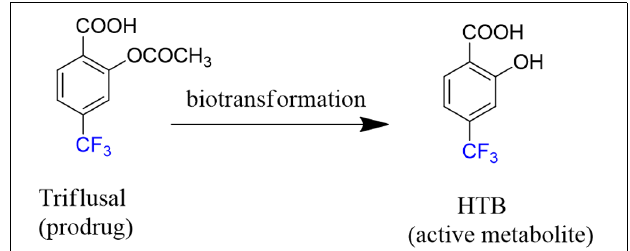
FIGURE 1 | Chemical structures of triflusal and its metabolite